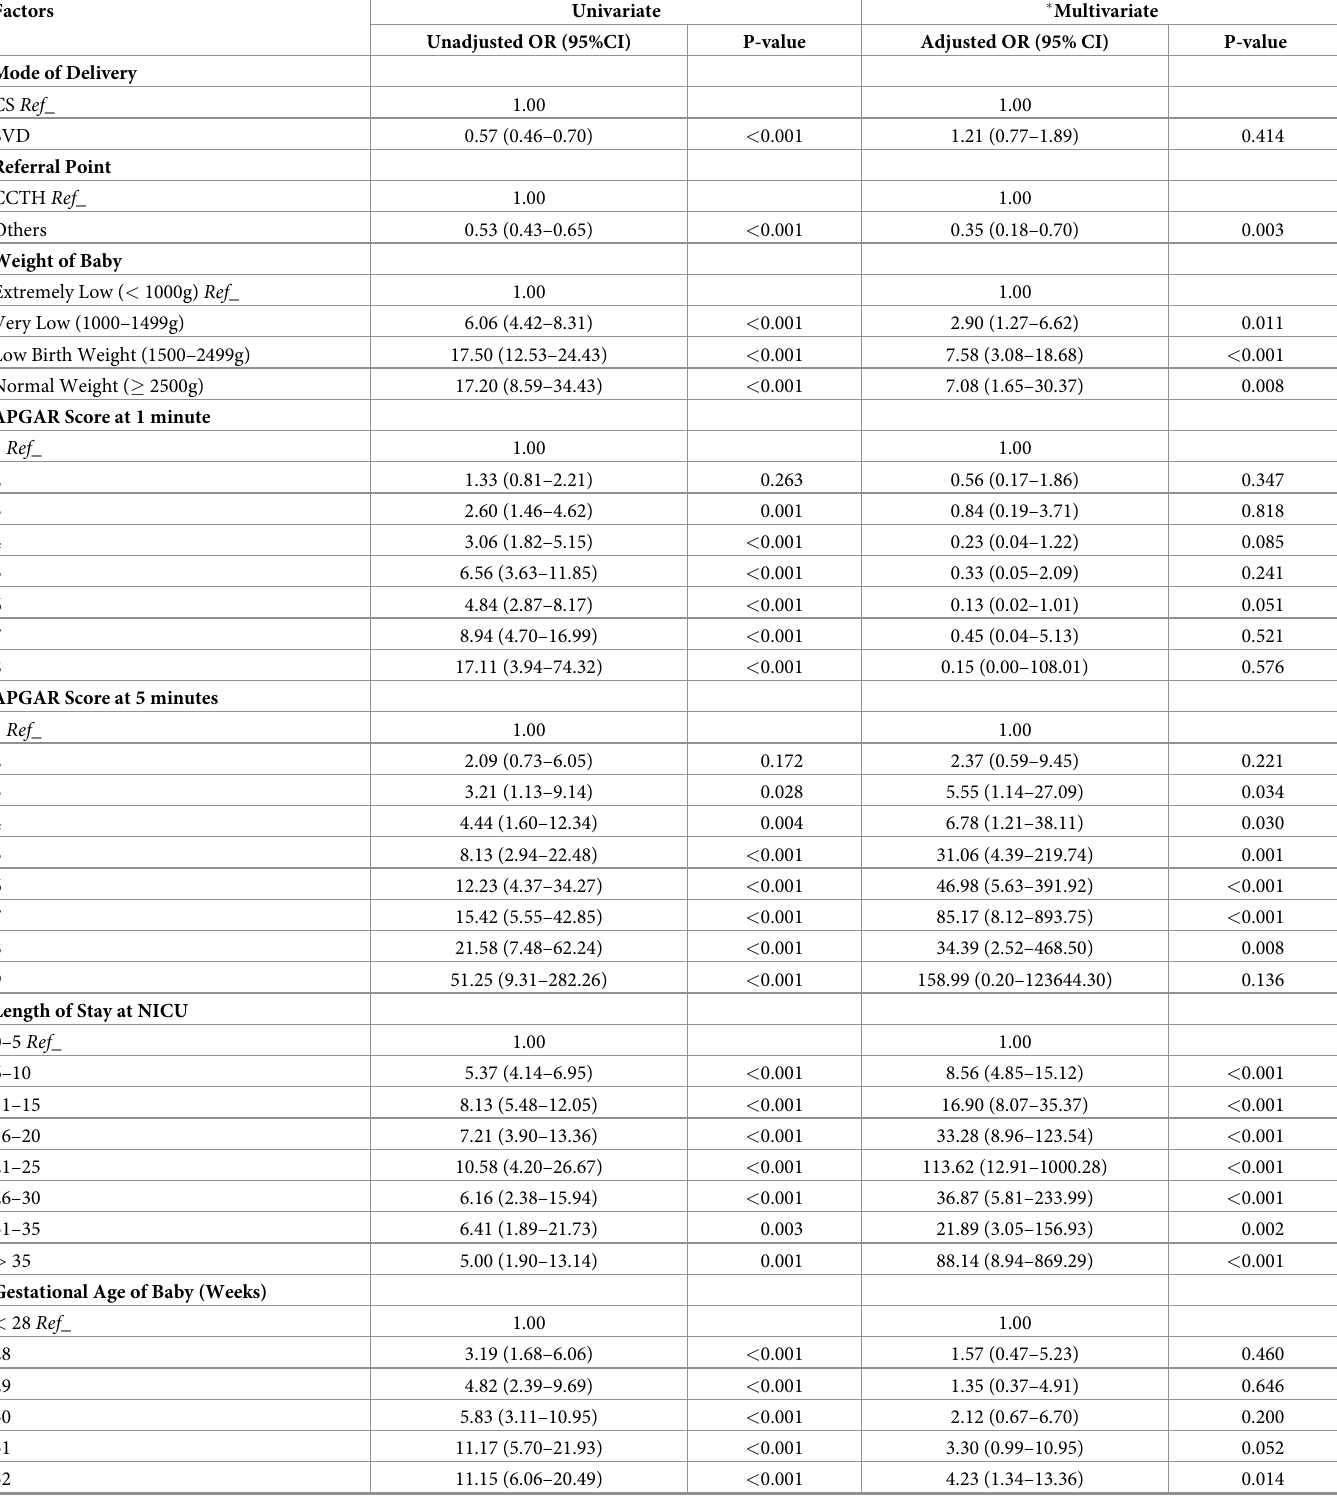
Table 3. Univariate and multivariate logistic regression analysis of factors associated with survival outcomes of preterm